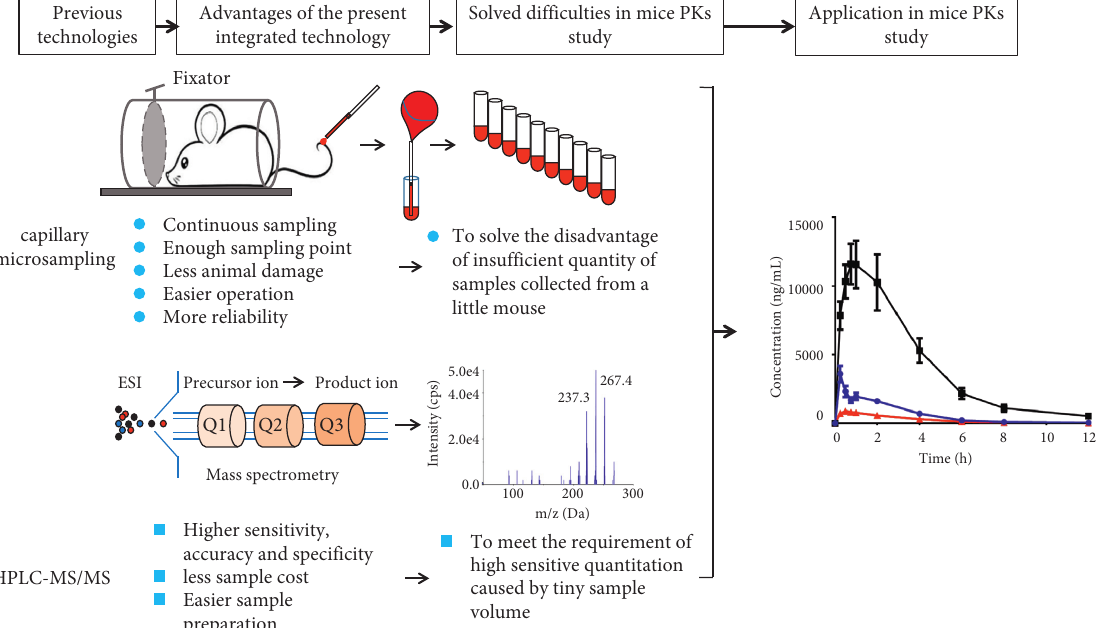
Figure 5: The advantages of a joint technology combined the CMS with HPLC-MS/MS in mice pharmacokinetic